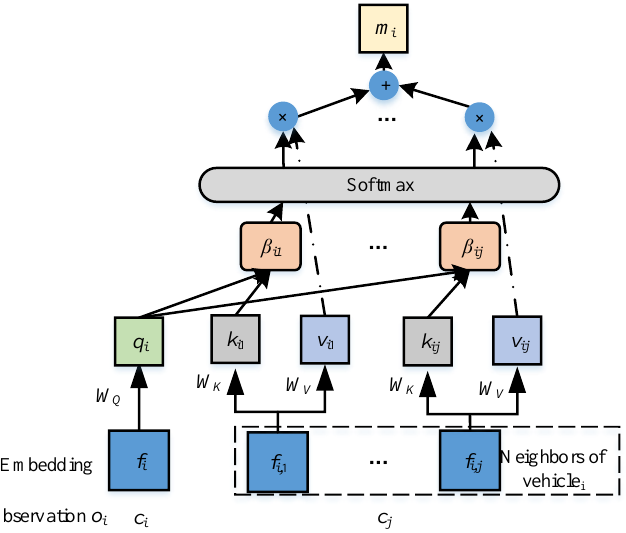
Figure 4. Flowcharts of the attention representation.